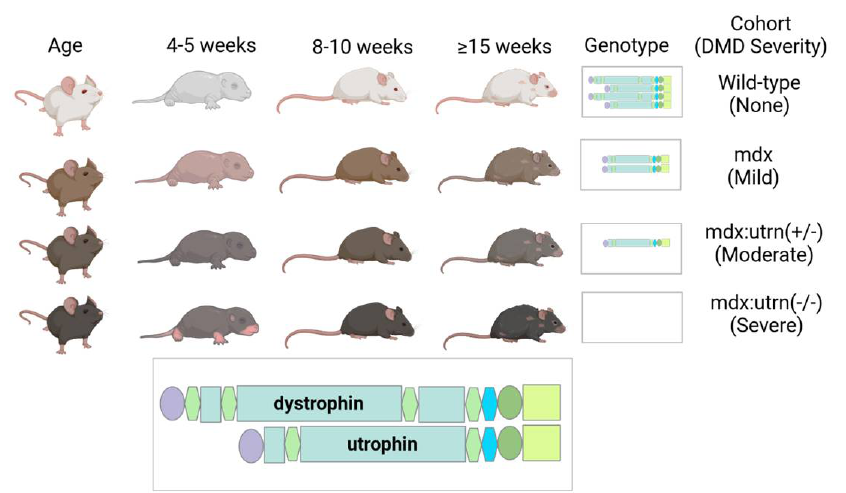
Figure 1. Murine models of DMD including the dystrophin-deficient mdx:utrn(+/−) mouse model used in this pilot study and the feasibility of modeling DMD symptom severity longitudinally with consideration for age-related effects.